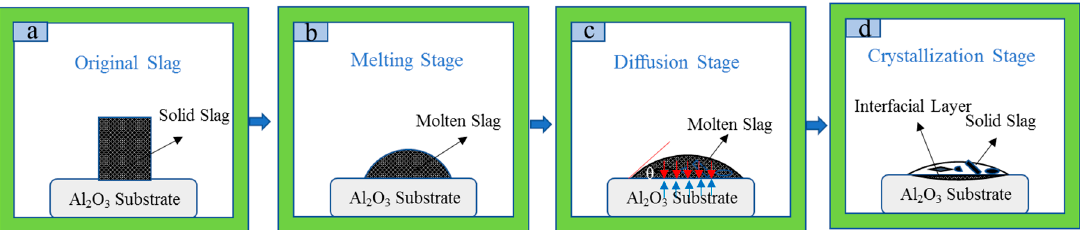
Figure 11. The schematic diagram of erosion mechanism.